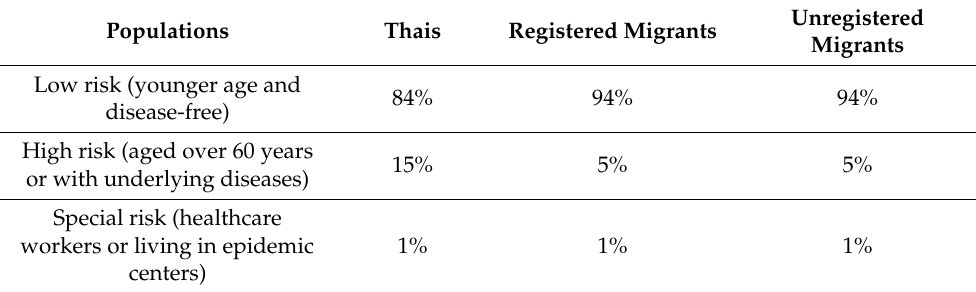
Table 2. Risk distribution of the target populations.